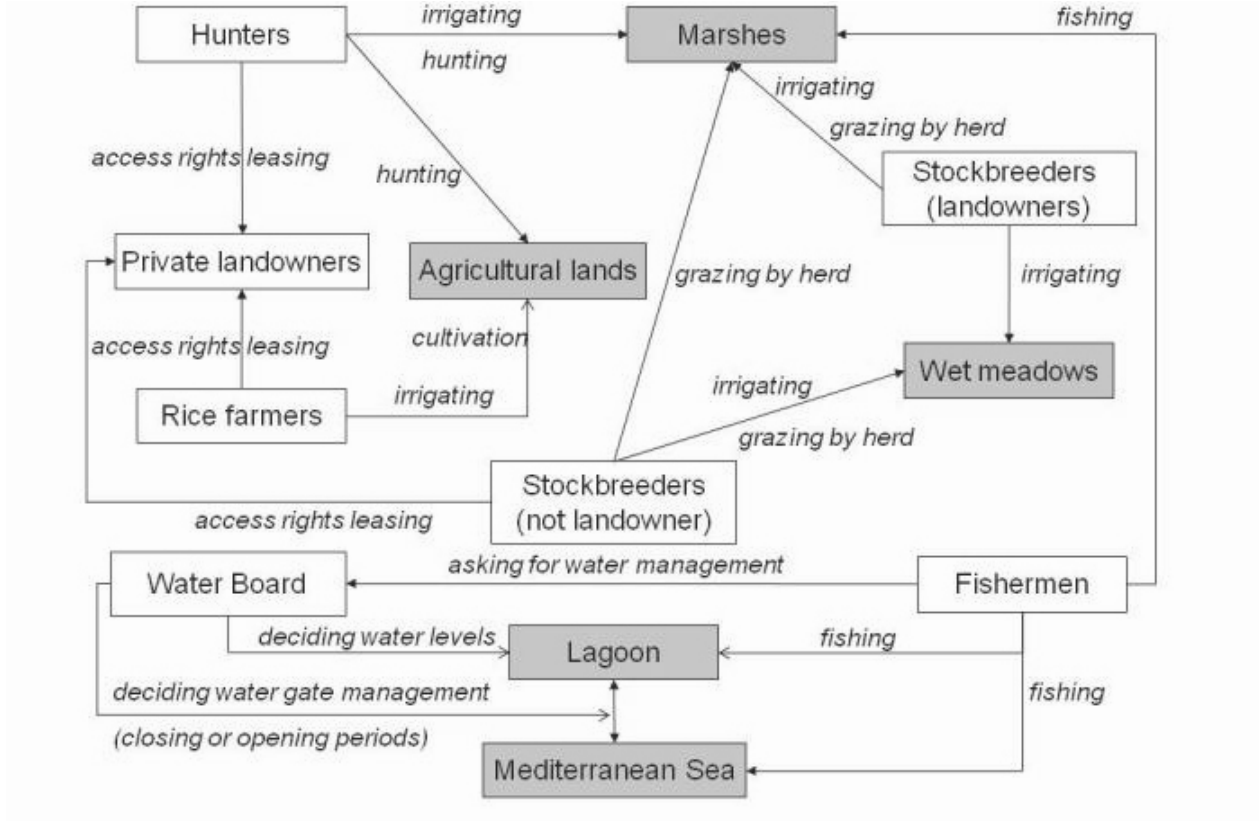
Fig. 1 . Example of completed representation of an individual mental model elicited with the ARDI